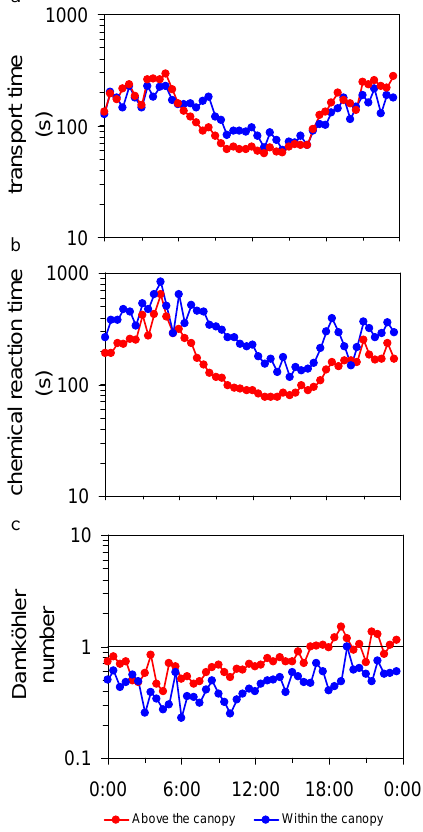
Fig. 6. Half-hourly medians of (a) transport times, (b) chemical re- Figure 6: Half hourly medians of (a) transport times, (b) chemical reaction times, and (c) 2 action times, and (c) Damk¨ohler numbers above (red symbols) and within (blue symbols) the canopy from 29 August to 20 Septem- Damköhler numbers above (red symbols) and within (blue symbols) the canopy from 29 3 ber August to 20 September 2005. 4